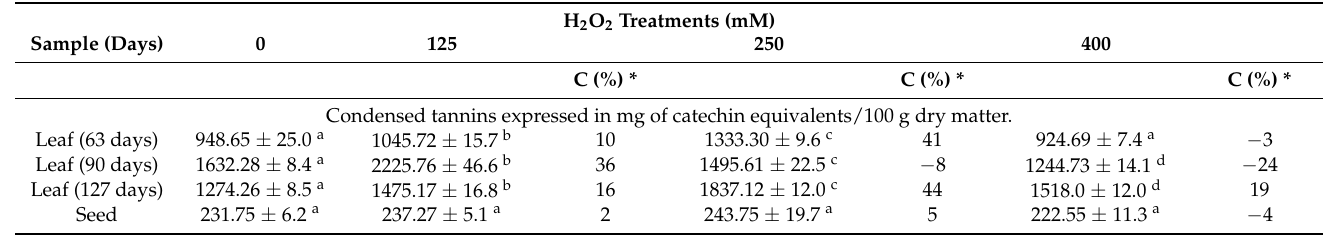
Table 5. Content of condensed tannins in amaranth leaf and seed ( Amaranthus hypochondriacus